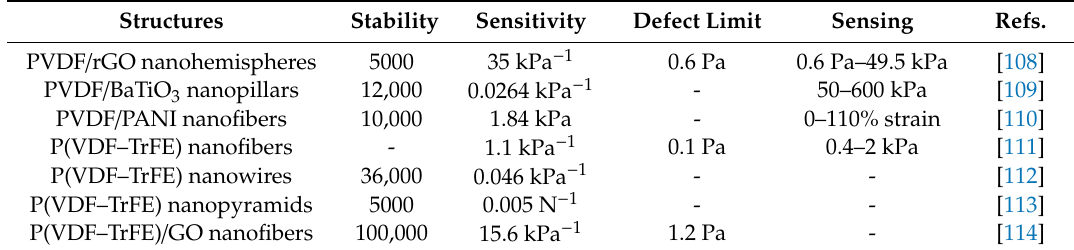
Table 4. Organic piezoelectric sensors with characteristic